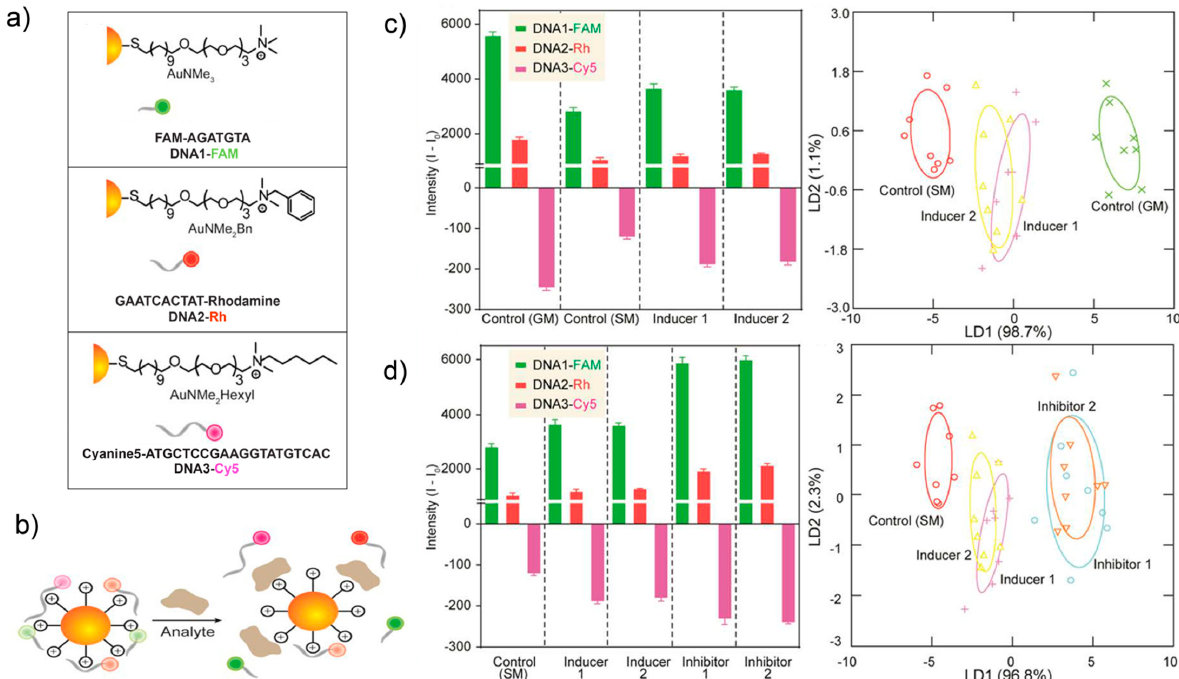
Figure 6. Multichannel DNA sensor array for detecting pharmacological effectors of catabolic pro- cesses. ( a ) The multi-channel sensor was created by complexing three different cationic AuNPs with different ssDNA sequences bearing distinguishable fluorescent signatures. ( b ) Competitive interac- tion between the quenched AuNP-DNA and the cell surface components creates a unique fluores- cence pattern. ( c ) Sensor array generated different fluorescent fingerprints against the treatment of autophagy modulators, and the pharmacological inducers of autophagy were separated in LDA plots. ( d ) Sensor array generated distinguishable fluorescent fingerprints between cells treated with autophagy inhibitors and inducers, and the accuracy of discrimination under LDA was 98%. Repro- duced with permission from [99]. Copyright 2019 American Chemical Society.